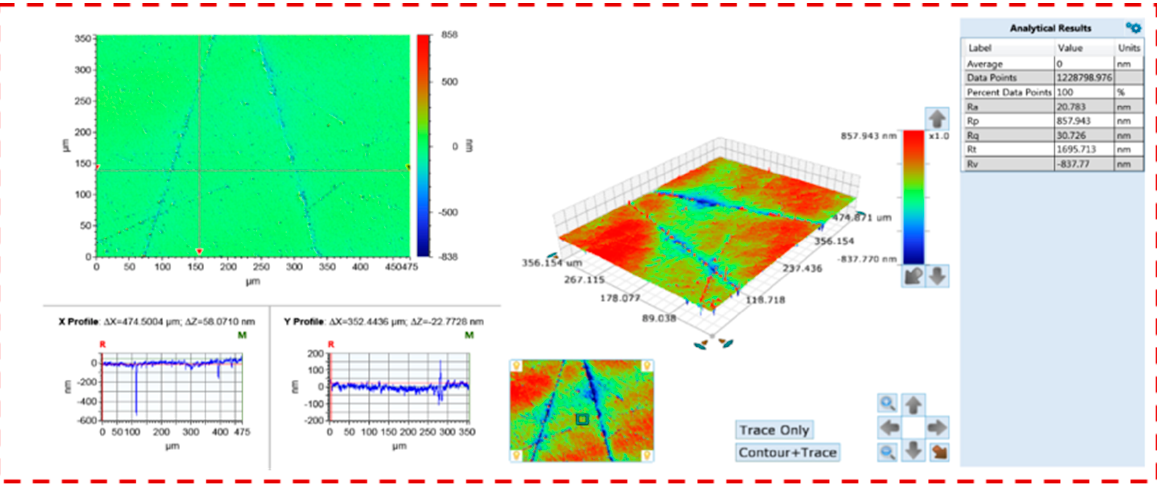
Figure 18. 2D and 3D morphologies and surface roughness of the C-plane surfaces after being polished by the free abrasive particles.